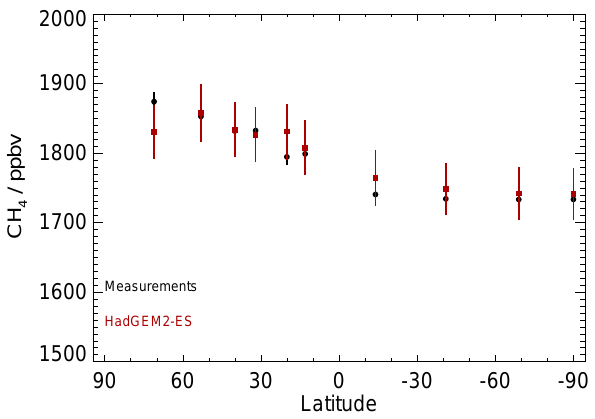
Fig. 14. Comparison of modelled methane concentrations for the 1990s compared with observations from a selection of sites from NOAA ESRL (Dlugokencky et al.,